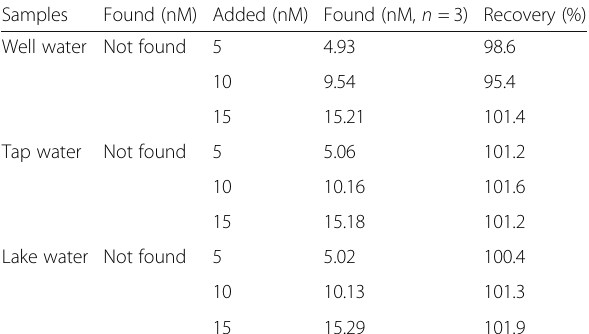
Table 3 The results of the determination for mercury ions in practical